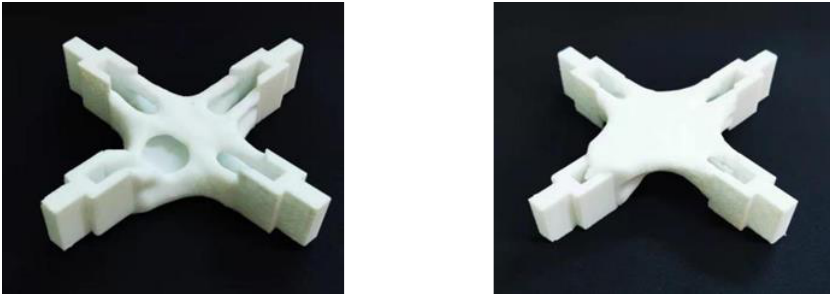
Figure 21. Print effect picture after improvement (combined working condition).